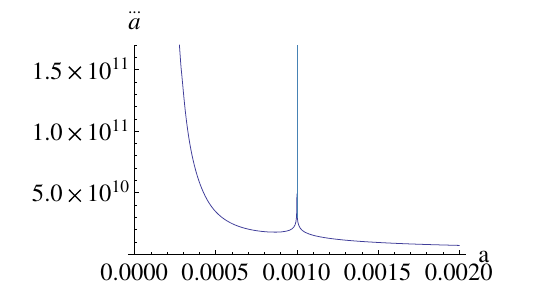
... a with respect to the